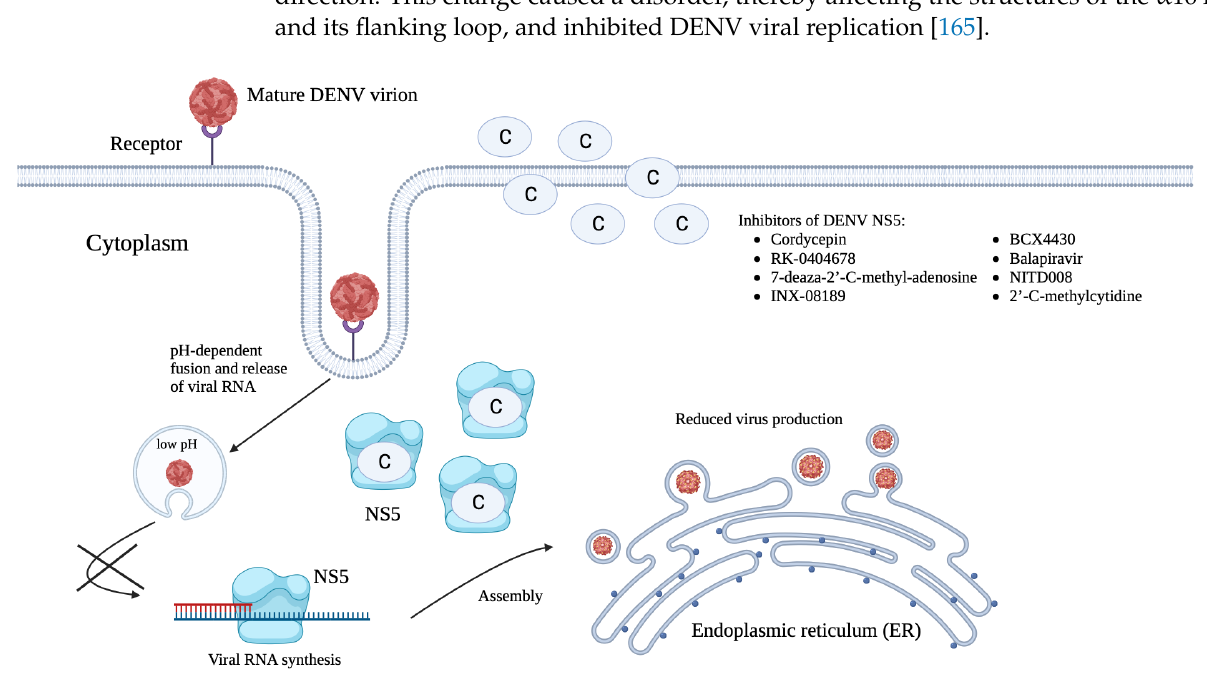
Figure 4. General molecular mechanism of compounds (labelled C) targeting DENV NS5. The binding of these compounds to DENV NS5 MTase and RdRp could possibly block the viral RNA synthesis step, resulting in inhibition of viral replication and reduced DENV production. The figure was created using Biorender.com (accessed on 7 March 2023). Table 4. Direct-acting antivirals of DENV targeting DENV non-structural